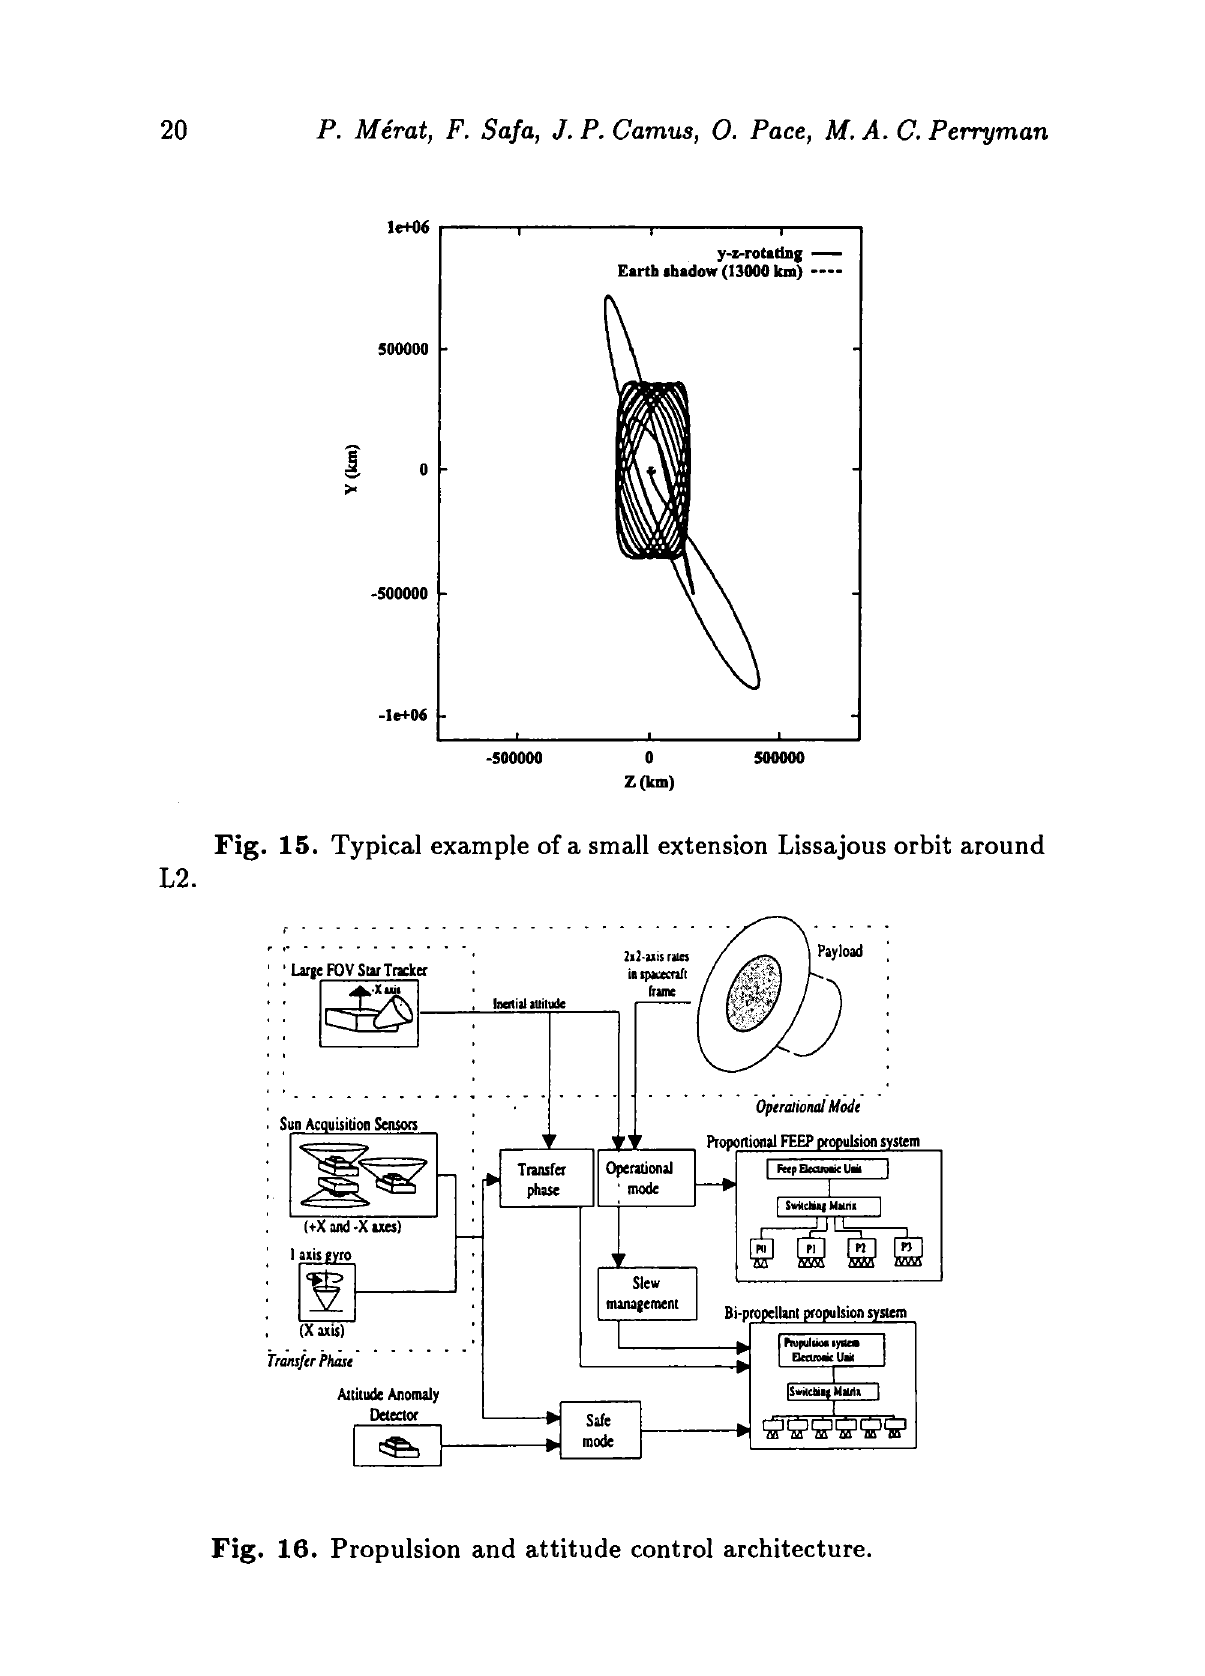
Fig. 16. Propulsion and attitude control